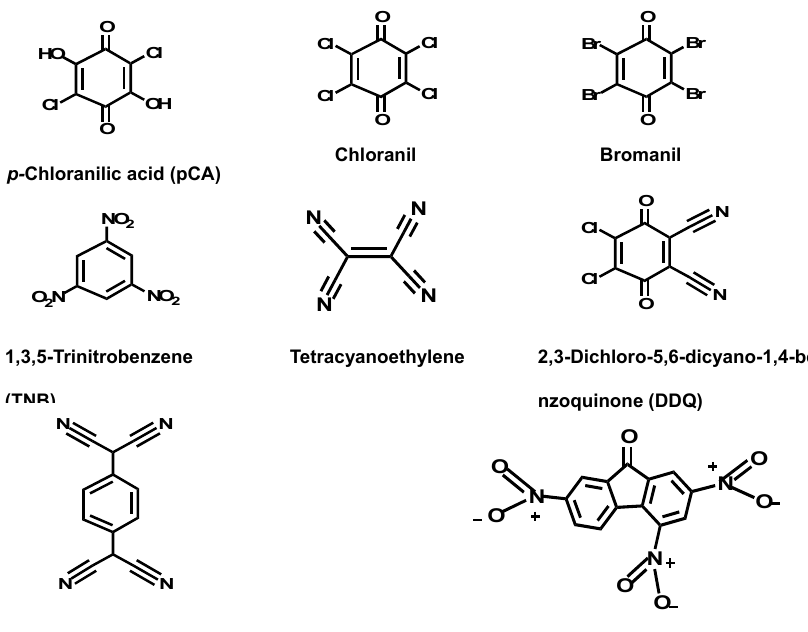
Figure 2. Chemical structures of the polyhaloquinone and polycyanoquinone π -acceptors used in the present